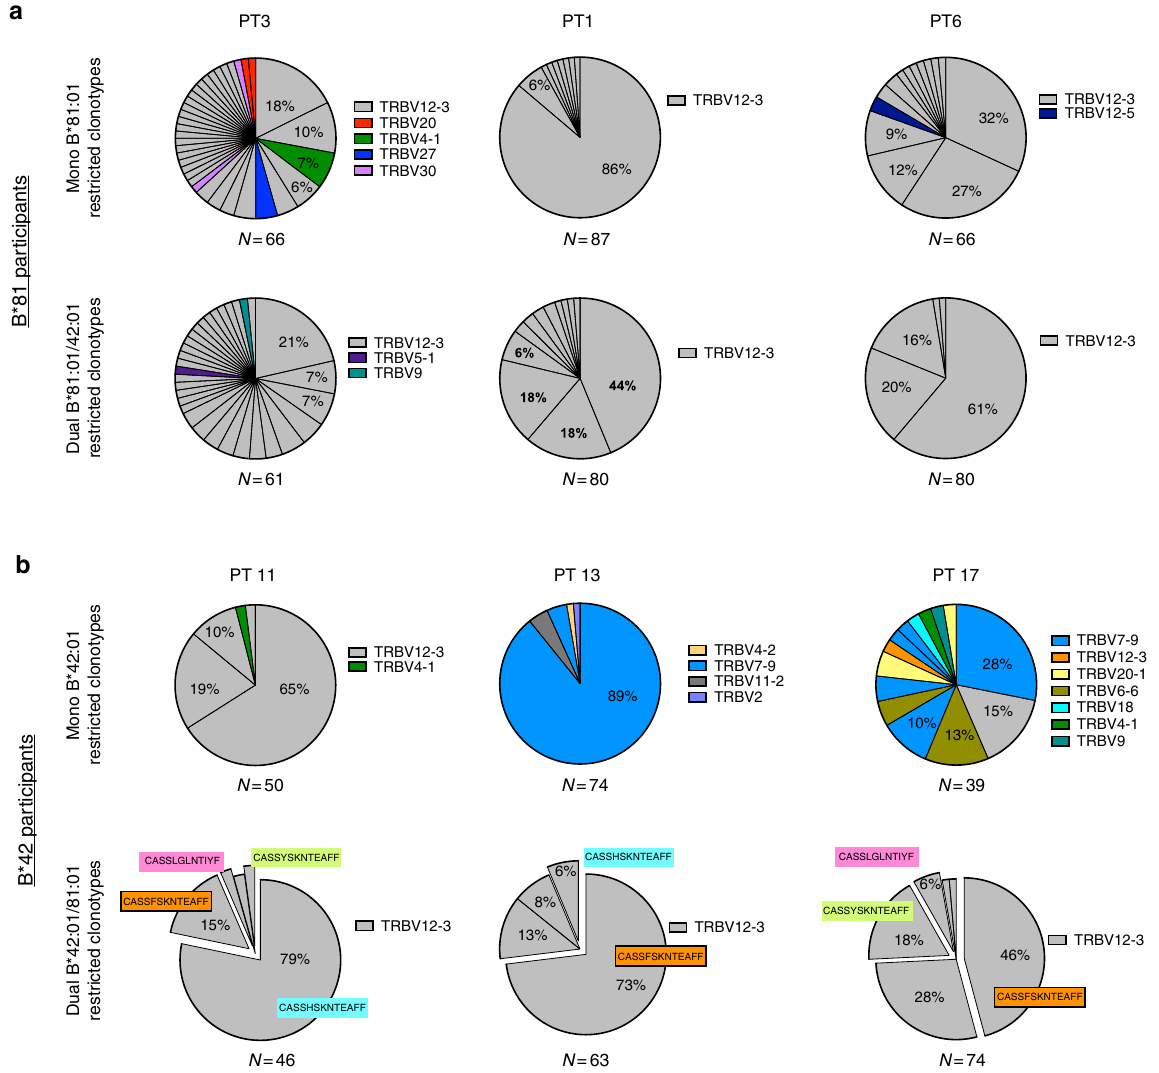
Fig. 3 Molecular analysis of TCR β clonotypes in mono- and dual-reactive T cells. TCR β sequencing was performed on single FACS-sorted mono- and dual- TL9 tetramer reactive T cells from three B*81:01 expressing participants ( a ) and three B*42:01 expressing participants ( b ). TRBV and CDR3 sequences were determined using the IMGT V-quest tool (www.imgt.org). The total number of sequences collected per population is indicated under each pie chart. Unique TCR β clones are displayed as wedges in the pie chart. The size of the wedge indicates the frequency of each sequence within the population and the color represents TRBV usage. TCR β sequences in mono- and dual-reactive populations from B*81:01 expressing individuals were highly enriched for TRBV12-3/12-4 usage (indicated in gray); however, no public sequences were observed among these individuals. Mono-reactive populations from B*42:01 expressing individuals encoded diverse TRBV and also lacked public sequences. In contrast, dual-reactive populations from B*42:01 expressing individuals were enriched for TRBV12-3/12-4 usage (gray), and these sequences were comprised predominately of four identical (public) TCR β clones (highlighted by colored boxes). Notably, these public clones were distinct from any TCR observed in B*81:01